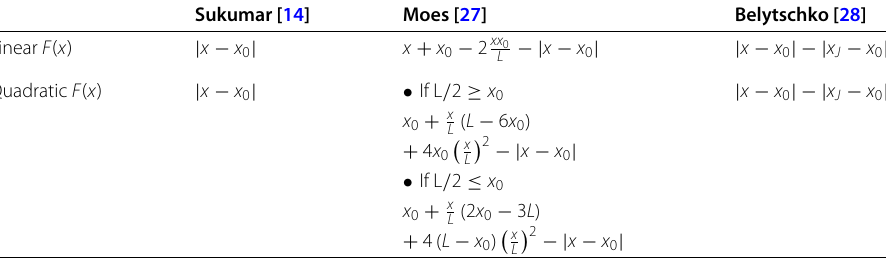
Table 4 Expressions of F ( x ) for weakly discontinuous enrichments with linear and quadratic approximations resulting from Table 3 for the one dimensional bi-material bar problem Sukumar [14] Moes [27] Belytschko [28] Linear F ( x ) | x − x 0 | Quadratic F ( x